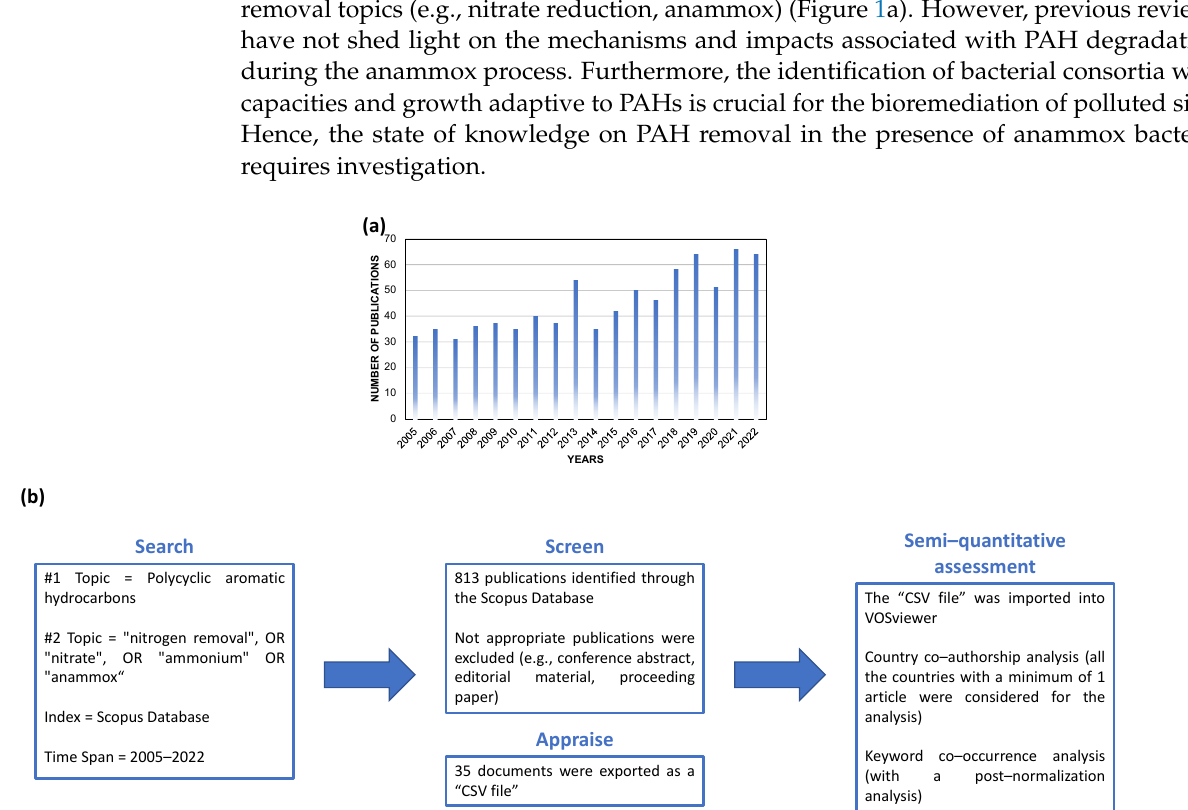
Figure 1. ( a ) Publications over time (i.e., from 2005 to 2022) identified by analyzing the keywords “polycyclic aromatic hydrocarbons” with “nitrogen removal” OR “nitrate” OR “ammonium” OR “anammox” in the Scopus database. ( b ) Flow chart of the literature screening procedure. The literature search was conducted on 27 November 2022.